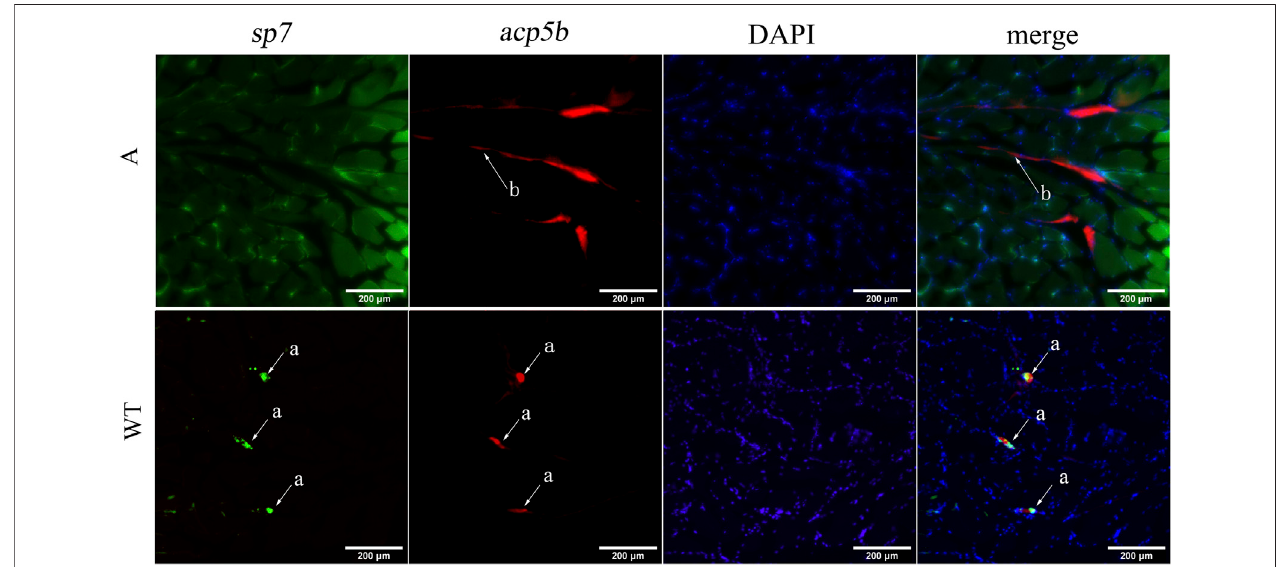
FIGURE6| RNA-FISHof acp5b inthetransversesection ofzebra fi shcaudalmusculoskeletontissues.WT:Tg(Ola.sp7-GFP); A:mutantofA:Tg(Ola.sp7-GFP)by crossing A mutants and Tg (Ola.sp7-GFP). The mRNA of acp5b was detected with Alexa Fluor 647 fl uorescent probes. a: IBs and b: myoseptum.